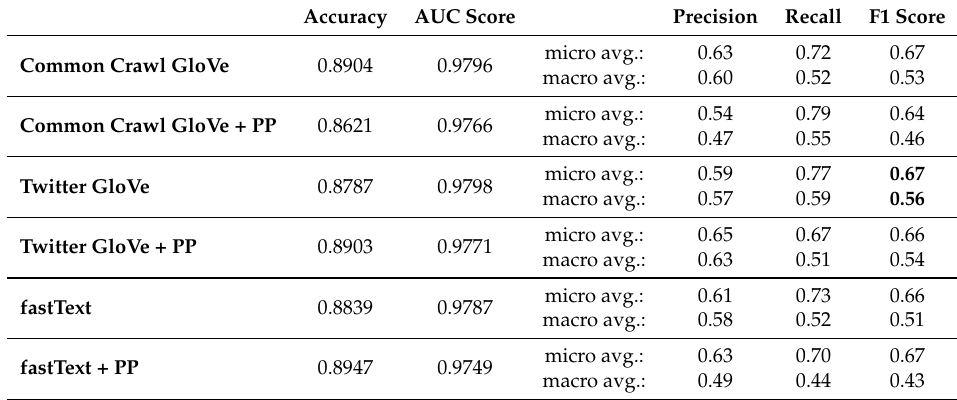
Table 9. Performance of the composed BiLSTM + CNN model with pre-trained GloVe and fastText